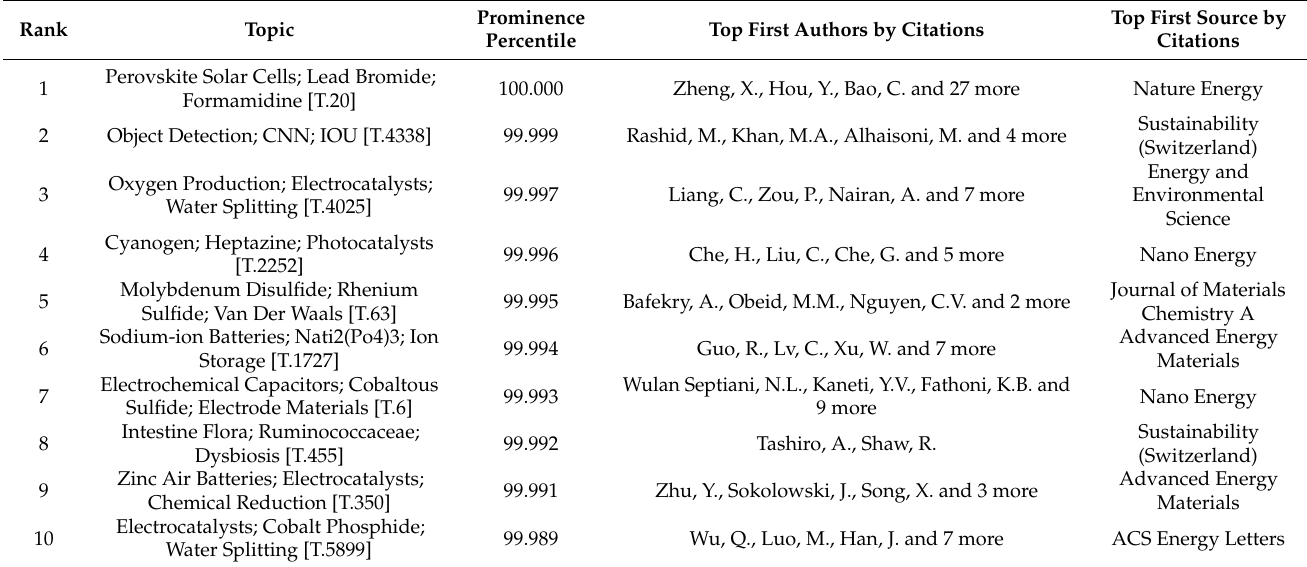
Table 2. Top 10 topics by prominence ranking that appear within renewable energy, sustainability and the environment, 2020–2021.